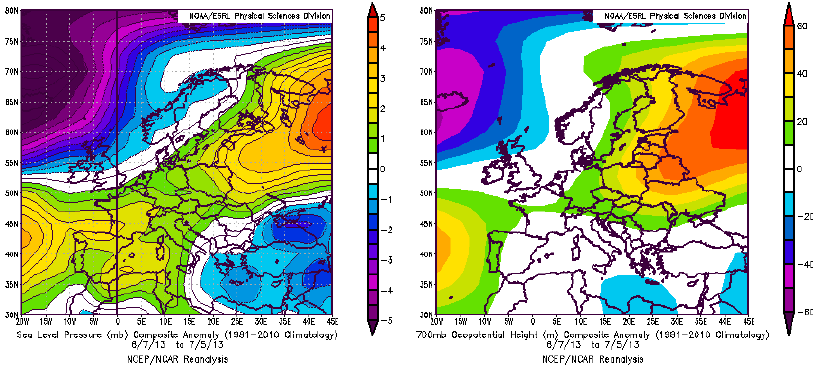
Figure 4. Sea level pressure in hPa (left) and 700hPa geopotential height in metres (right) composite mean anomalies over the period from 7 June to 5 July 2013 with respect to the 1981–2010 climatology obtained from the NCEP/NCAR Reanalysis (images provided by the NOAA/ESRL Physical Sciences Division, Boulder Colorado, from their web site at